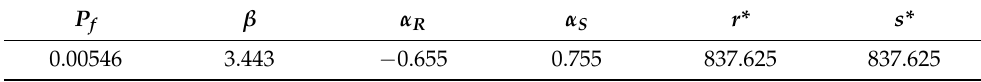
Table 6. Results of reliability analysis.